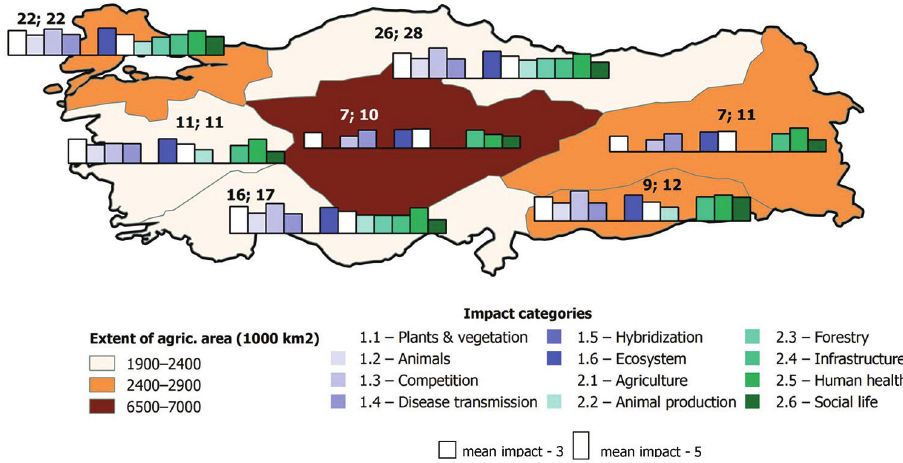
Figure 2. Map of impact types per individual geographical region. Shading of the regions reflects the extent of agricultural area (thousands of km 2 in that region; TUIK 2015). The heights of the bars in the main figure are proportional to the assessed impact of alien species in the regions; two bars with mean impacts of 3 and 5 are shown as a reference. Numbers above the bars show the number of species with environmental and socioeconomic impact in the region.